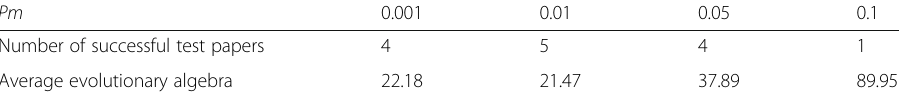
Table 5 The effect of parameter variation probability on the convergence of the algorithm Pm 0.001 0.01 0.05 0.1 Number of successful test papers 4 Average evolutionary algebra